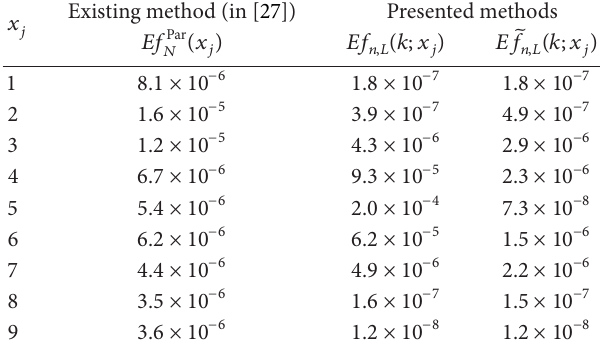
Table 3: Relative errors for the Blasius function 𝑓(𝑥) .